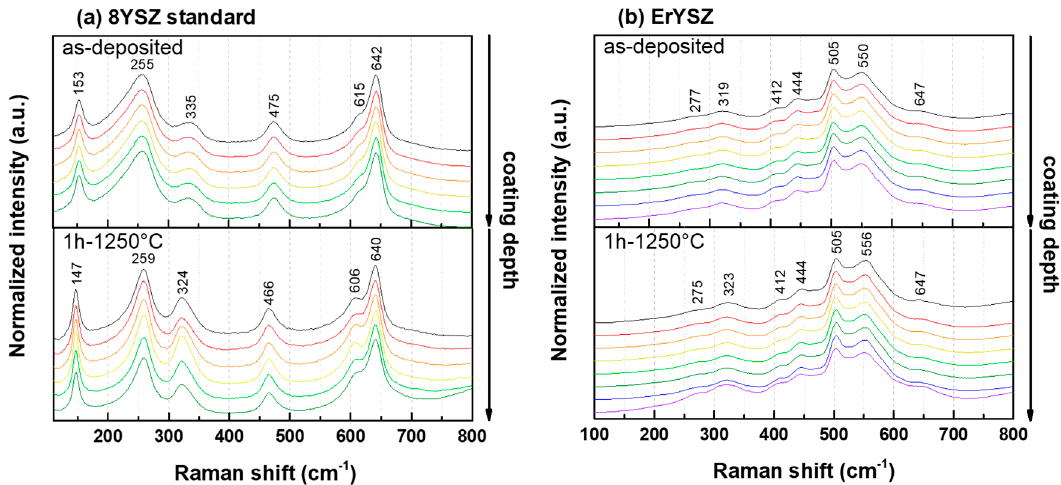
Figure 2. Raman spectra of ( a ) the 8YSZ standard and ( b ) Er 2 O 3 -Y 2 O 3 co-stabilised ZrO 2 (ErYSZ) coatings in their as-deposited conditions and after annealing in air at 1250 °C for 1 h.